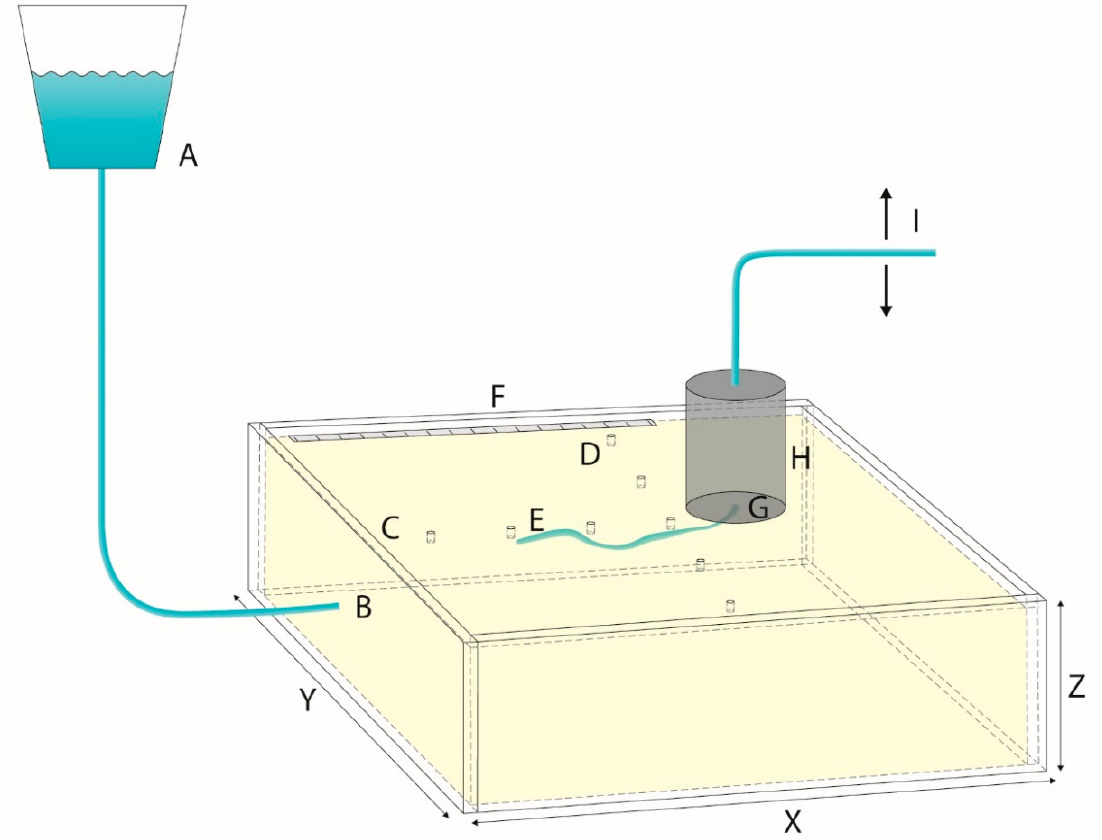
Figure 3. Experiment container used in this study, internal dimensions of the box containing the sample: X: 48.55 cm; Y: 30.1 cm; Z: 10.0 cm. A: Container with constant head; B: Inlet 20 cm wide and across the height of the box. C: Covering Perspex plate to observe the pipe. D: filters in the Perspex plate for riser tubes. E: Pipe developing in the sample. F: Measuring tape. G: outflow point of the sample. H: Cylindrical container for catching the outflowing sample and water. I: Outflow point, can